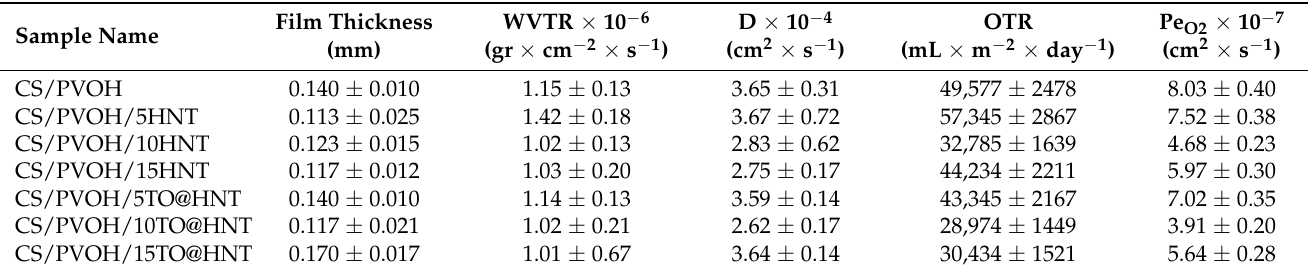
Table 2 . Film thickness, water vapor transmission rate (WVTR), water diffusivity (D), oxygen transmission rate (OTR), and oxygen diffusivity (Pe O2 ) values of pure CS/PVOH film as well as CS/PVOH/HNT and CS/PVOH/TO@HNT films.